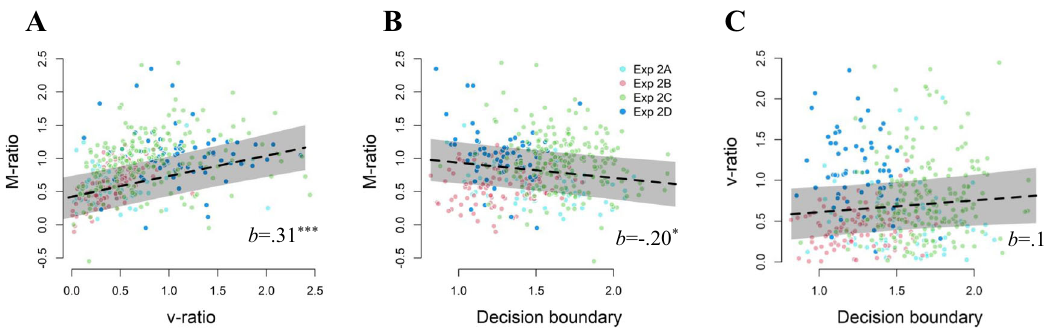
Fig. 3 The in fl uence of spontaneous variations in speed-accuracy tradeoff on metacognitive accuracy. We investigated four different datasets (equaling a total N = 430) from experiments in which participants did not receive any instructions concerning speed or accuracy. Results from a hierarchical mixed effects model show that across the four datasets, there is a positive relation between M-ratio and v-ratio, b = 0.31, p < 0.001 ( A ), a negative relation between M-ratio and decision boundary, b = − 0.200, p = 0.015 ( B ), and no relation between v-ratio and decision boundary, b = 0.11, p = 0.233 ( C ) Note: the regression line shows the estimate from the hierarchical model fi t, transparent bands show the 95% con fi dence interval. Each dot re fl ects one participant, with the color depending on the dataset. Source data are provided as a Source Data fi